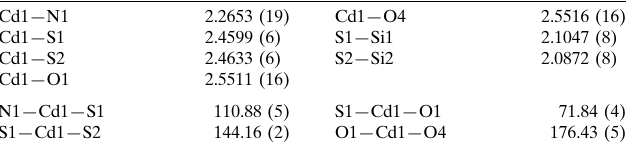
Selected geometric parameters (A˚ , (cid:2) ).